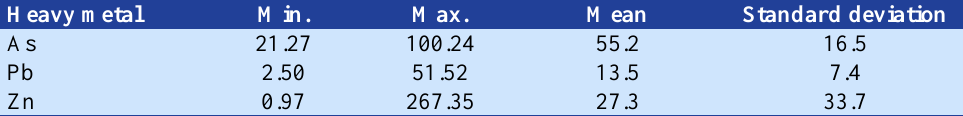
Table 1. Statistical properties of dataset Heavy